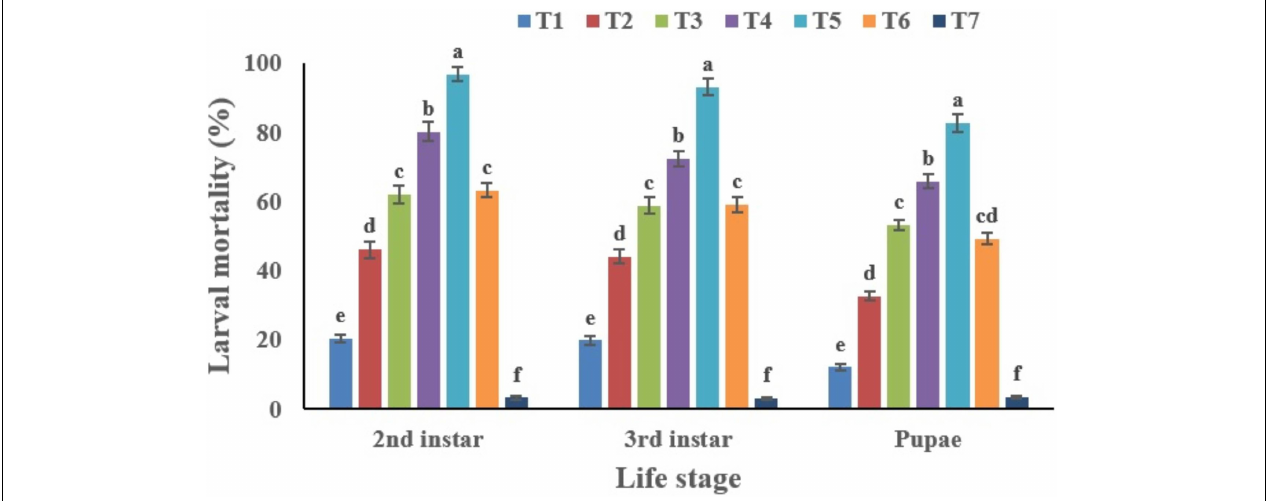
FIGURE 10 | Percentage mortality of Bemisia tabaci immatures in response to different treatments of Cordyceps fumosorosea -biochar nanoparticles and control after 7 days. *T1 = 5.0 ppm C . fumosorosea -biochar nanoparticles; T2 = 7.5 ppm C . fumosorosea -biochar nanoparticles; T3 = 10.0 ppm C . fumosorosea -biochar